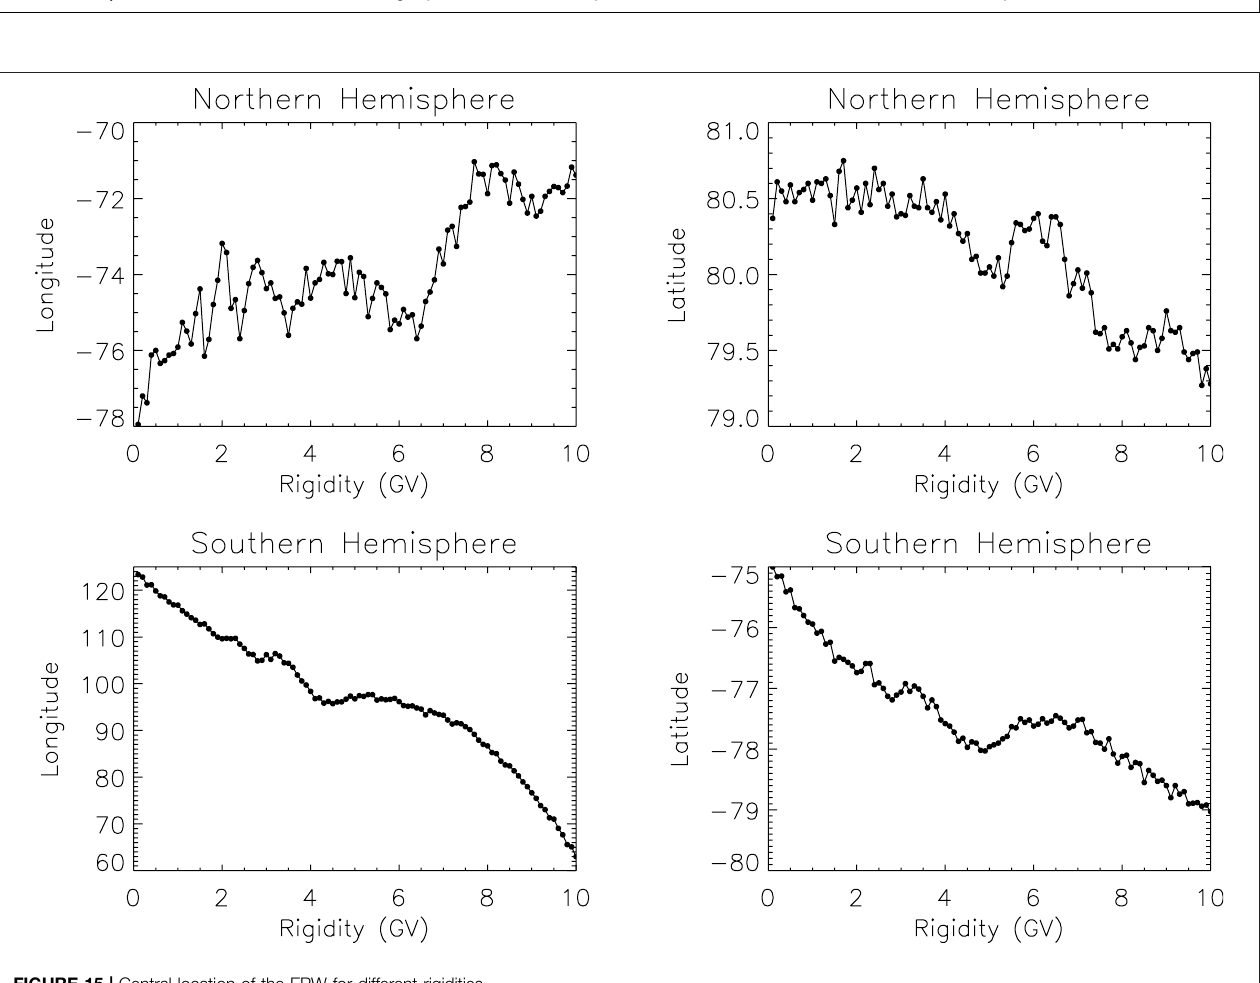
Frontiers in Earth Science |